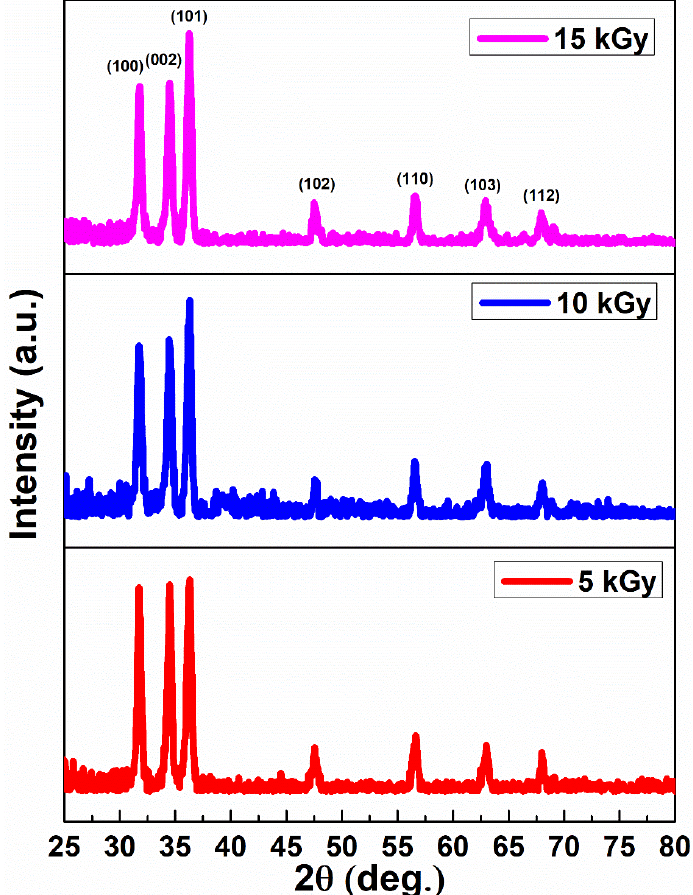
Figure 2. XRD pattern of irradiated IZO thin films.